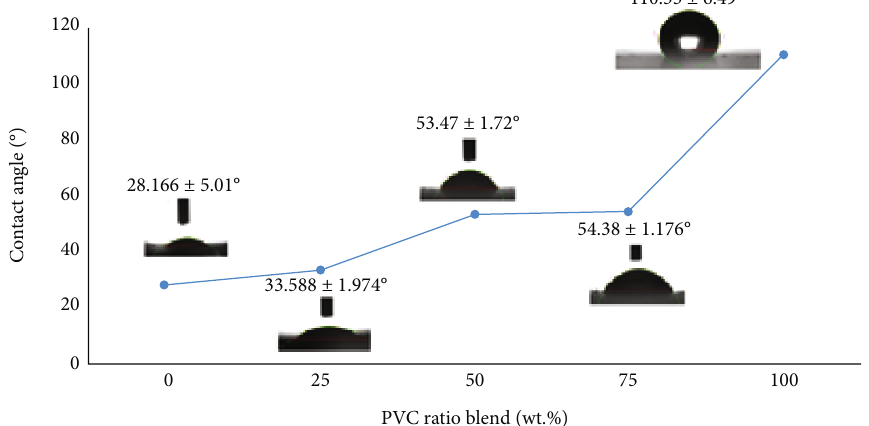
Figure 3: Changing of the water contact angles on the surface of PVC: PAN nano fi bers dependent on increased of the PVC wt. % content in PVC: PAN